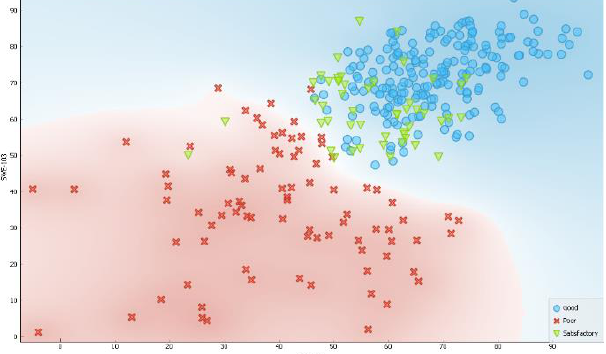
Fig. 2 . Scatter plot demonstrating the relationship between SWE-102 and SWE-103 of Cohort